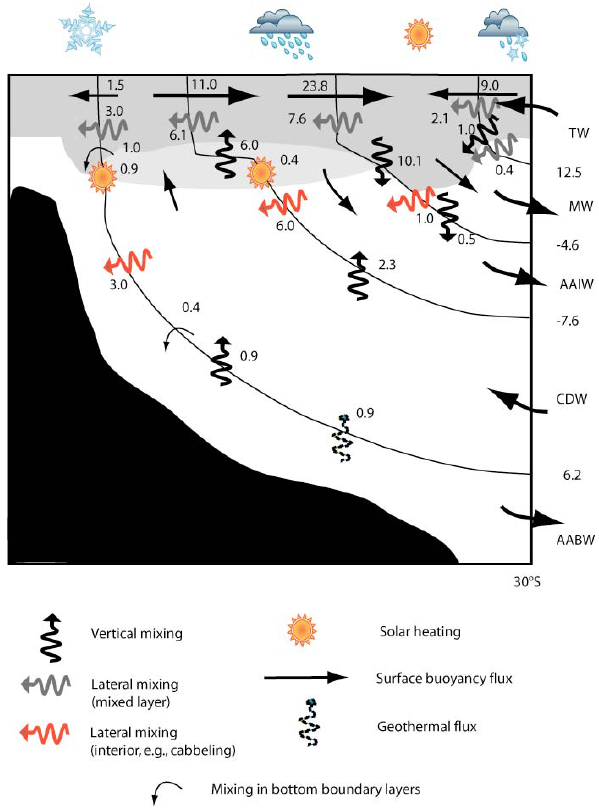
Fig. 6. Sketch of the principal DIC dianeutral transports due to water mass transformations in the model. Units are in PgCyr − 1 . Numbers on the right refer to the net dianeutral DIC transport (pos- itive values correspond to transport toward larger densities). The dark shaded region is the region of annual maximum mixed layer depth while the light shaded region is the stratified region impacted by the solar heating. For a discussion of assumptions made in the computations in Iudicone et al.